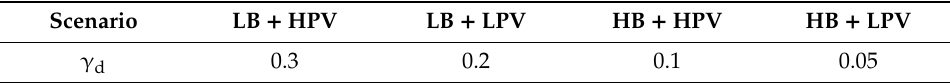
Table 3. Battery discharge e ffi ciency degradation factor, γ d